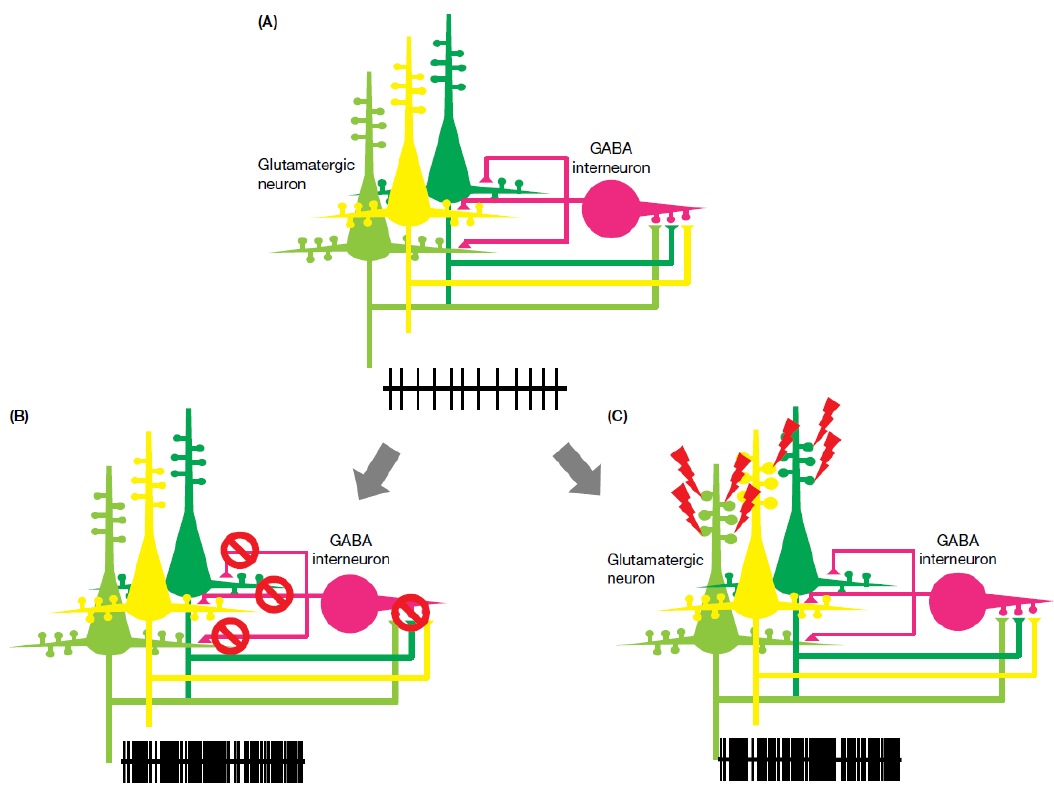
Figure 1. Physiological and pathological N-methyl-D-aspartate (NMDA) receptor function. ( A ) Physiological interaction between excitatory and inhibitory neurons. ( B ) Hypo-NMDA function: excitatory input to the inhibitory neuron is diminished by hypo-function of the NMDA receptor; the silencing of an inhibitory neuron results in an increase in excitatory neuron firing. ( C ) Hyper-NMDA function: a gain-of-function mutation could enhance neuronal excitation. NMDA, N-methyl-D- aspartate; GABA, gamma aminobutyric acid.